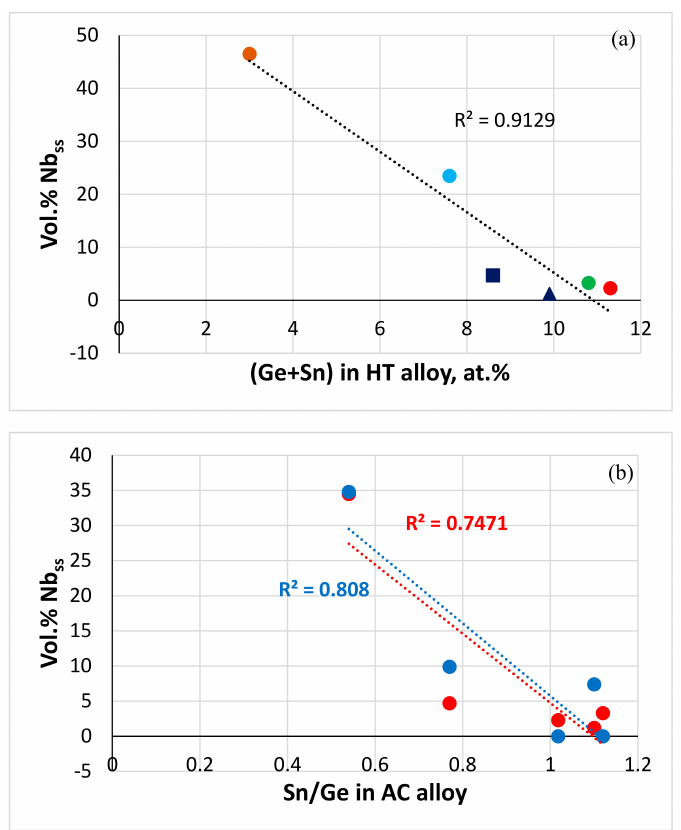
Figure 9. Volume fraction Nb ss as function ( a ) of Ge + Sn in heat-treated alloys and ( b ) of Sn / Ge in as-cast alloys. In ( a ) data for HT alloys, JZ1, JZ2 [46], JZ3, JZ3 + [47], with red for JZ5, green for JZ4, triangle for JZ3 + , square for JZ3, blue for JZ2, and brown for JZ1. All data R 2 = 0.9129, and data for Ta-containing alloys R 2 = 0.942. In ( b ) data for cast alloys JZ2 to JZ5, red filled circles for experimental data, and blue circles for calculated data using NICE. AC = as cast, HT = heat